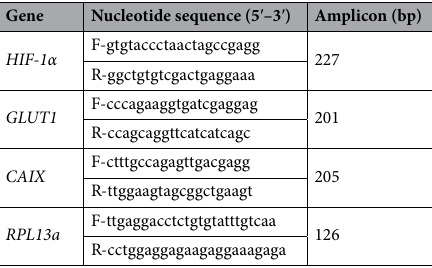
Table 1. Characteristics of specific